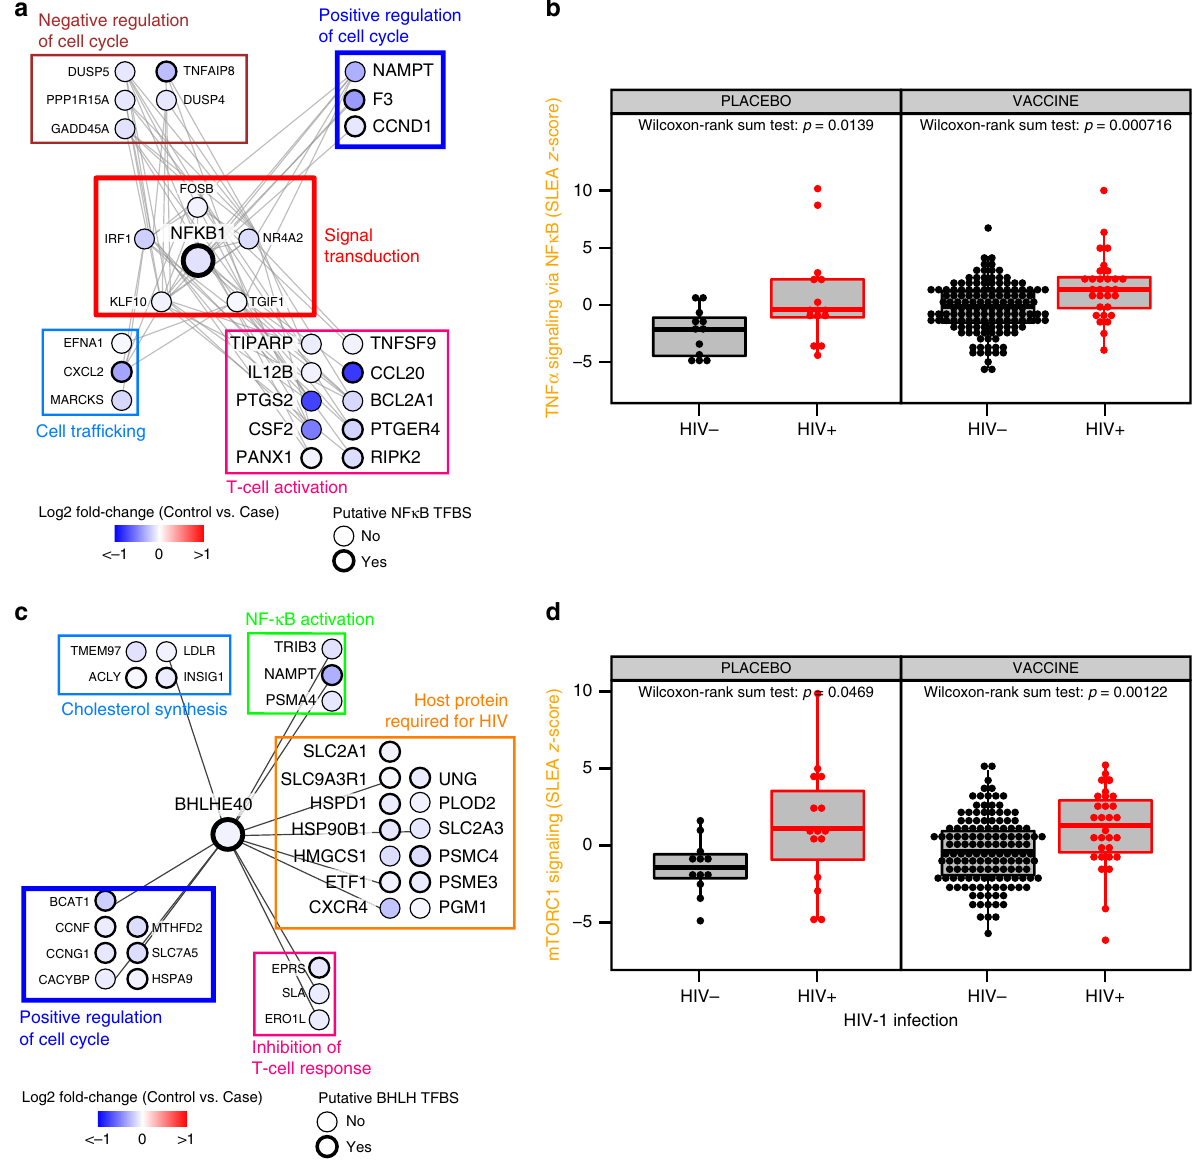
Fig. 6 Mechanisms associated with increased risk of HIV-1 acquisition. a Network showing the genes implicated in NF- κ B signaling. Nodes correspond to genes; the color of a node is proportional to the log2 fold-change between controls and HIV-1 cases. Edges are inferred by GeneMANIA and correspond to physical interactions, colocalization. or co-expression. The remaining genes part of this signature but with unknown/unrelated functions can be found in Supplementary Data 5. b Boxplot presenting the association of genes implicated in NF- κ B signaling and HIV-1 acquisition, separately for placebo recipients and vaccinees. Wilcoxon-rank sum test was performed to assess the signi fi cance of the association between the transcriptomic data and HIV-1 acquisition. On the boxplot, the lower whisker, the lower hinge, the midhinge, the upper hinge and the upper whisker correspond to the interquartile (IQR) from the fi rst quartile, the fi rst quartile, the median, the third quartile and the IQR from the third quartile, respectively. c Network showing the genes implicated in mTORC1 signaling. Nodes correspond to genes; the color of a node is proportional to the log2 fold-change between controls and HIV-1 cases. Edges are inferred by GeneMANIA and correspond to physical interactions, colocalization, or co-expression. The remaining genes part of this signature but with unknown/unrelated functions can be found in Supplementary Data 5. d Boxplot presenting the association of genes implicated in mTORC1 signaling and HIV-1 acquisition, separately for placebo recipients and vaccinees. Wilcoxon-rank sum test was performed to assess the signi fi cance of the